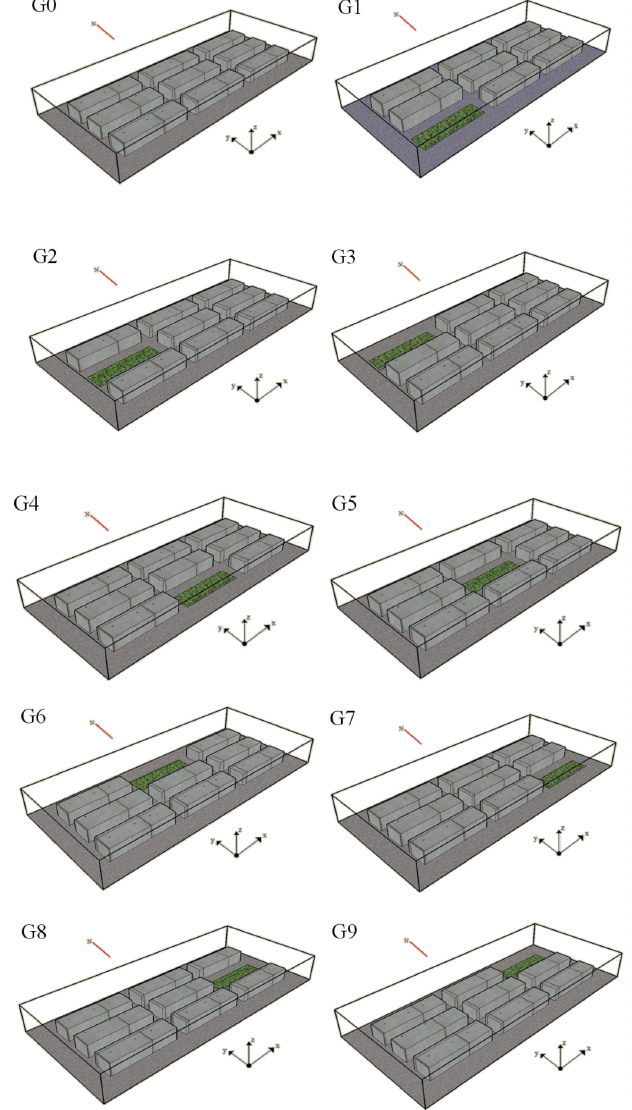
Figure 5. Green space layout of the CFD-simulated